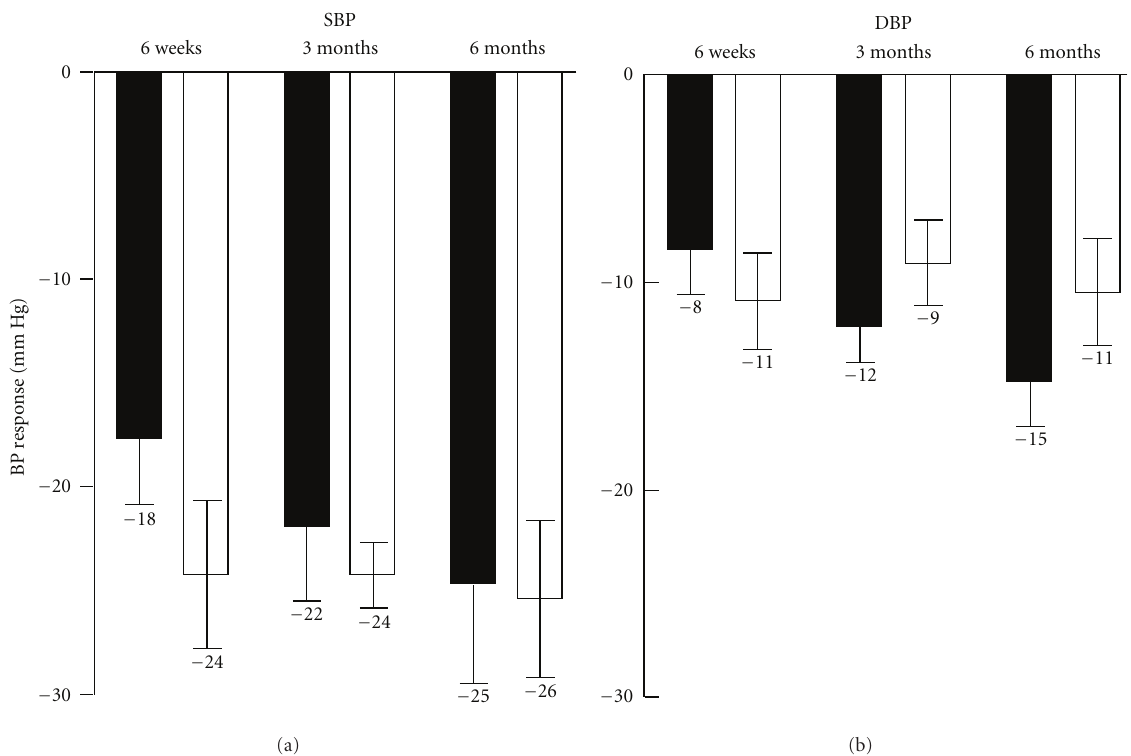
Figure 1: BP reduction achieved after low-dose spironolactone was added to the antihypertensive regimen in patients with RHTN, with (filled bars) or without (open bars) PA